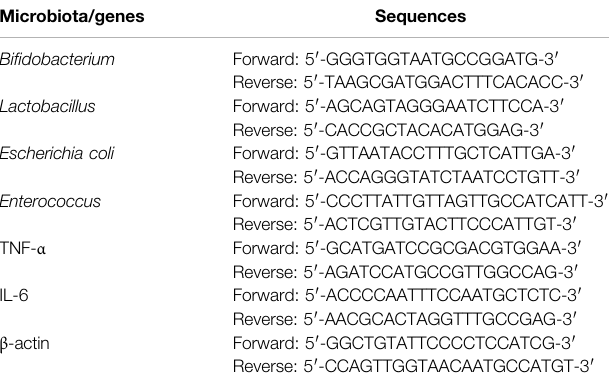
TABLE 1| Primer sequencesused forgutmicrobiota and in fl